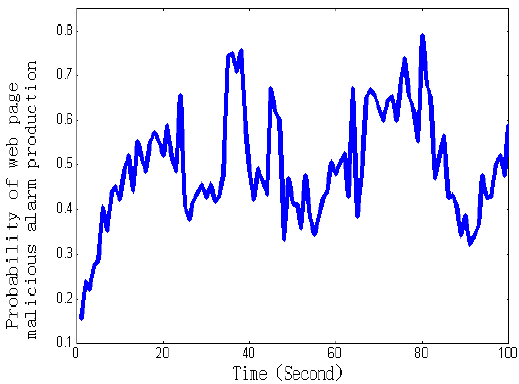
Fig. 10. The probability of Malicious JavaScript script